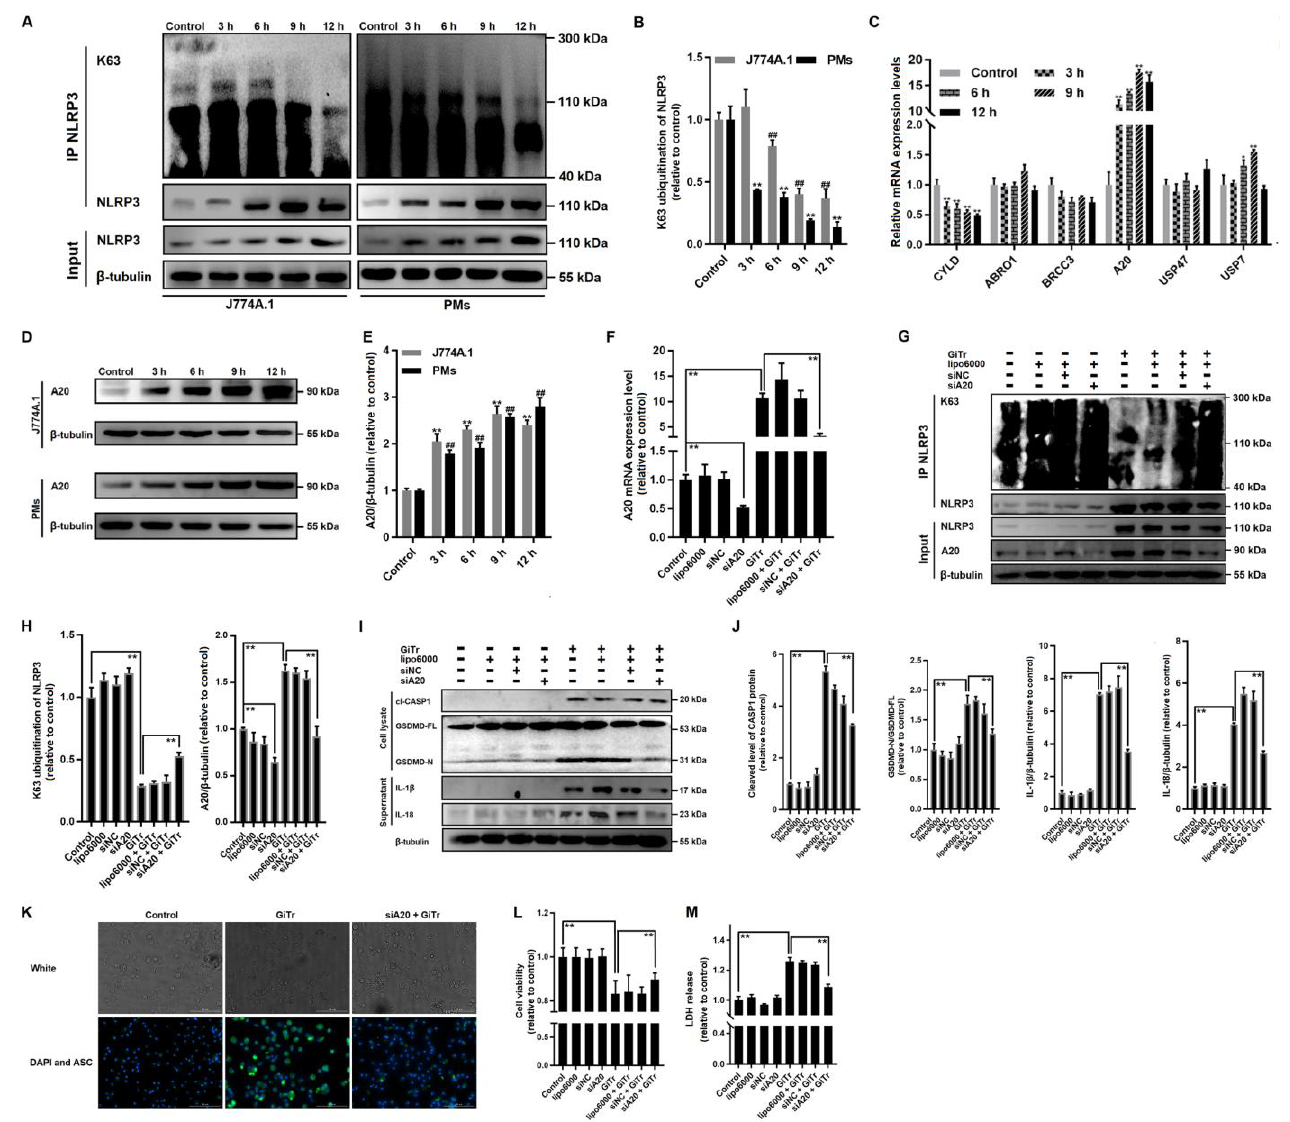
Figure 4. Involvement of A20-mediated NLRP3 deubiquitination in Giardia -induced macrophage pyroptosis. J774A.1 cells or PMs were treated with trophozoites at a ratio of 10 parasites/cell for the indicated time periods. ( A , B ) The levels of K63-linked ubiquitination of NLRP3 were assessed by co-IP analysis. ( C ) The mRNA expression levels of candidate DUBs in PMs were assessed by qPCR. ( D , E ) The protein level of A20 was analyzed by Western blotting. ( F – M ) PMs were transfected with siA20 or scrambled siRNA for 48 h and treated with trophozoites for 12 h. ( F – H ) The efficiency of A20 knockdown was detected by qPCR and Western blotting. ( G , H ) The effects of siA20 on NLRP3 deubiquitination and in- flammasome activation induced by Giardia were analyzed by co-IP. ( I , J ) The effects of siA20 on Giardia -induced cleavage of CASP1 and GSDMD and IL-1β and IL-18 secretion were assessed by Western blotting. ( K ) Immunofluorescence anal- ysis showed that siA20 affected ASC expression in Giardia -treated PMs (scale bar = 100 μm). ( L , M ) The effects of siA20 on decreased cell viability and enhanced LDH release induced by Giardia . All experiments were repeated at least three times. ( A , D , G , I , K ) Representative pictures are shown. ( B , C , E , F , H , J , L , M ) Values are expressed as the mean ± SD (* p < 0.05, ** , ## p < 0.01 as compared to nontreated controls or as indicated). GiTr: reads Giardia trophozoites. 3.5. Involvement of TLR4 Activation in Giardia-Induced Macrophage Pyroptosis TLRs play vital roles in the innate reaction to microbial products and transmit spe- cific immune responses against pathogens [22]. Here we evaluated the mRNA expression levels of TLR2, TLR3, TLR4, and TLR5 in Giardia -treated and untreated PMs (Figure 5A), among which only TLR2 and TLR4 showed a marked increase in expression ( p < 0.01). Flow cytometry analysis indicated that TLR2 and TLR4 were strongly upregulated at 12 h